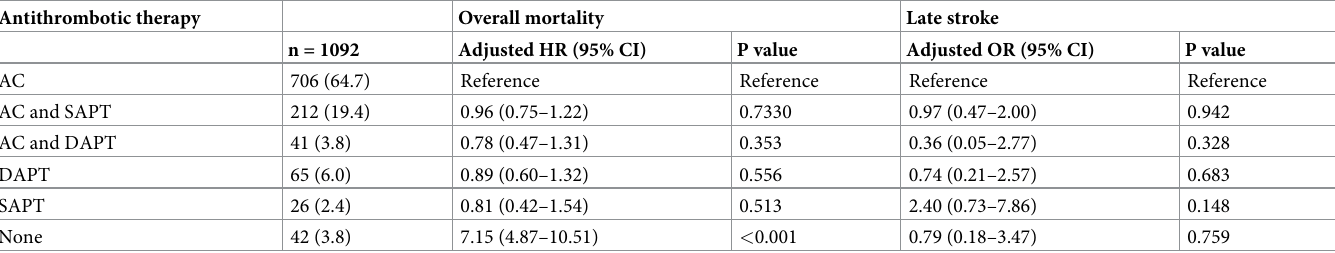
Table 3. Antithrombotic therapy among patients with atrial fibrillation at the time of discharge from the operative center. Antithrombotic